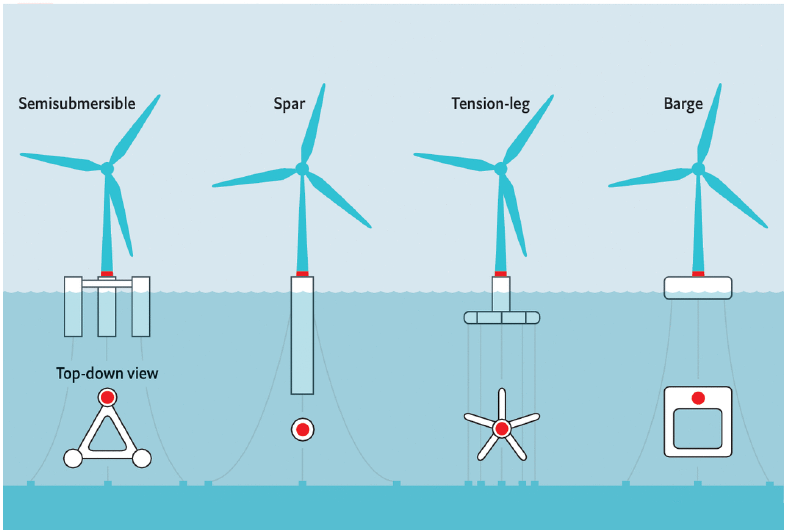
Figure 2. Different FOWT design concepts [40].